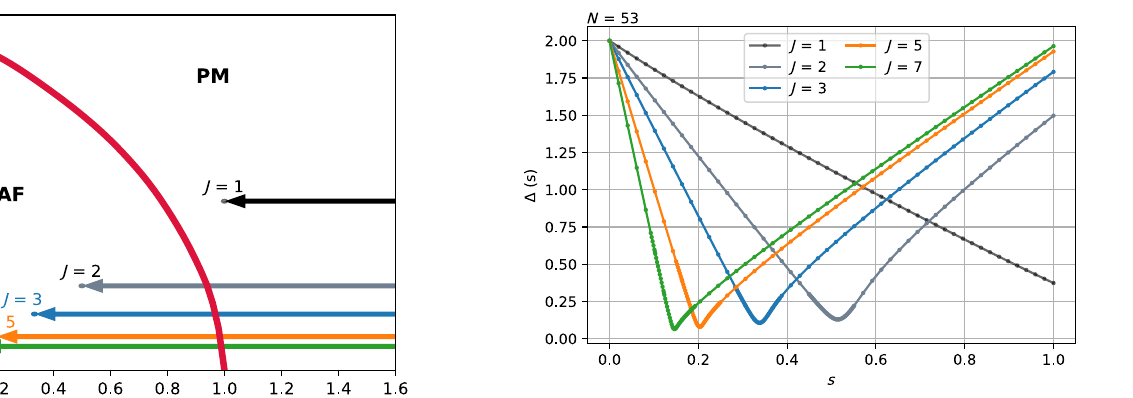
FIG. 8. The spectral gap (cid:2)( s ) for the ZZXZ model for N = 53 qubits and different values of J , obtained using DMRG meth- ods. The energy difference between the ground state and the first excited state is plotted along the adiabatic path in s . The min- imal spectral gap along the adiabatic path is smallest for large interaction strength J and the phase transition is crossed earlier in parametrized time s